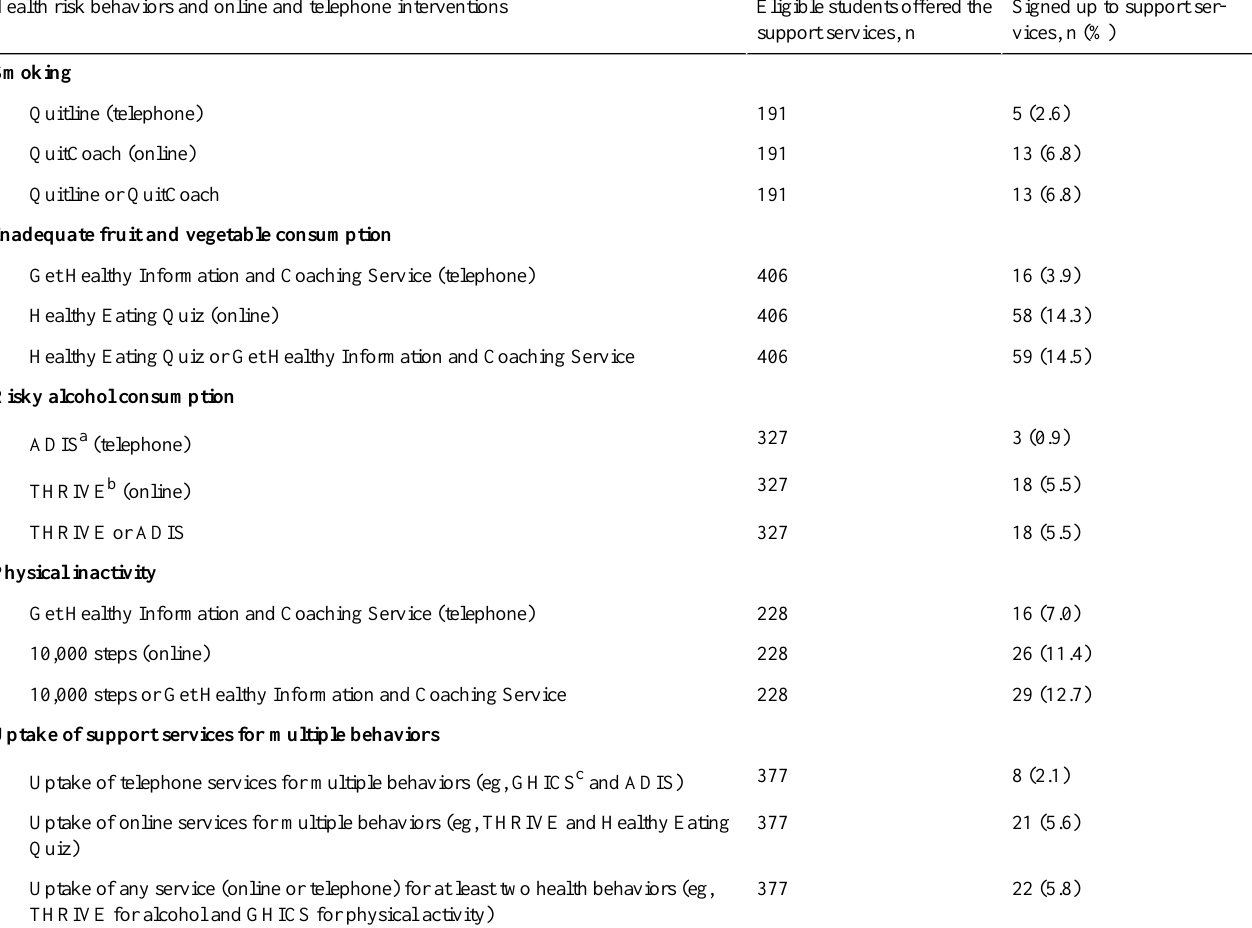
Table 3. Uptake of proactively offered online and telephone support services (N=551).